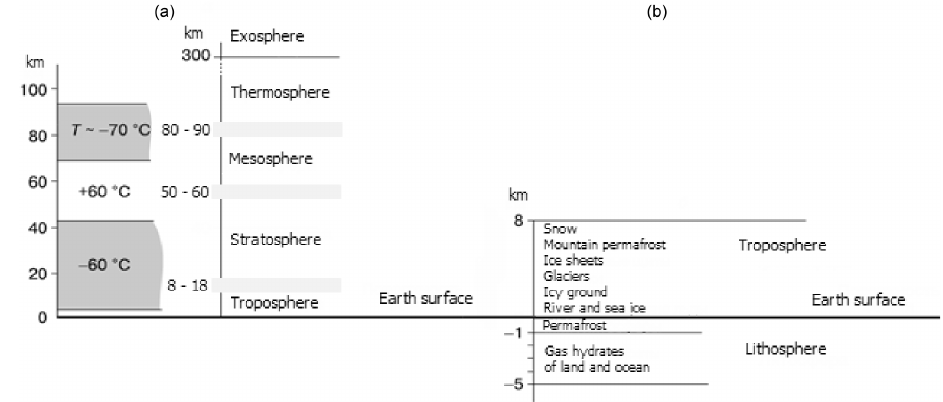
Figure 1. The Earth’s cryosphere: from (a) the uppermost atmosphere, to (b) 5km below Earth’s surface, where ice exists as hydrates at positive temperatures (Melnikov and Gennadinik, 2011).